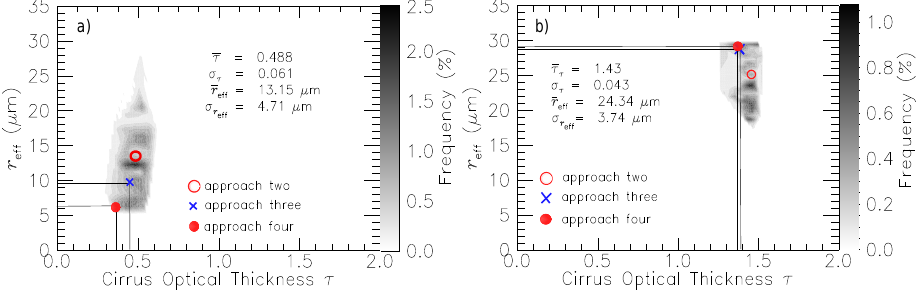
Fig. 11. Frequency distribution of τ and r eff of two HALO-SR measurement examples (a) 40601s, (b) 40795s for the flight of 4 November, 2010 using approach two. The red filled dot indicates the result for assuming the mean surface albedo of approach four compared to retrieval using the frequency distribution of approach two values (blank dot). The blue cross indicates the retrieval assuming the mean albedo given within a 10 km footprint below the plane for the measurement timestamp (approach three)